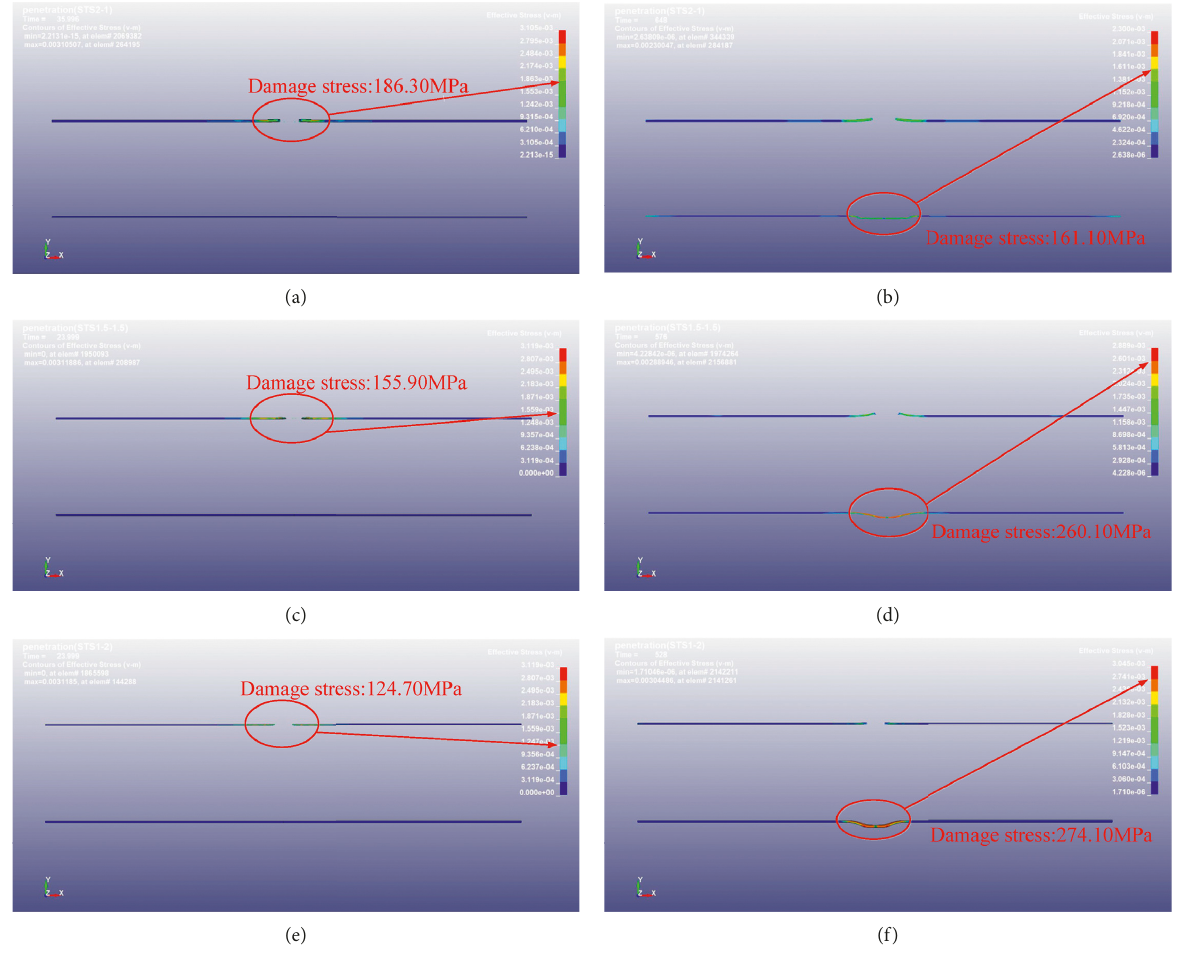
Figure 13: Damage nephograms of the front F and rear R steel liners under impact loading (1/2): (a) 2-1-F; (b) 2-1-R. Damage nephograms of the front F and rear R steel liners under impact loading (2/2): (c) 1.5-1.5-F; (d) 1.5-1.5-R; (e) 1-2-F; (f) 1-2-R.